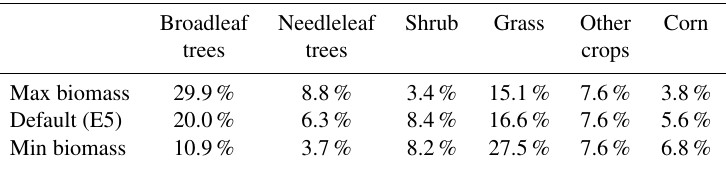
Table 6. The area fractions of different plant functional types (PFTs) in Beijing from the CCI LC with maximum biomass, minimum biomass and default cross-walking tables.